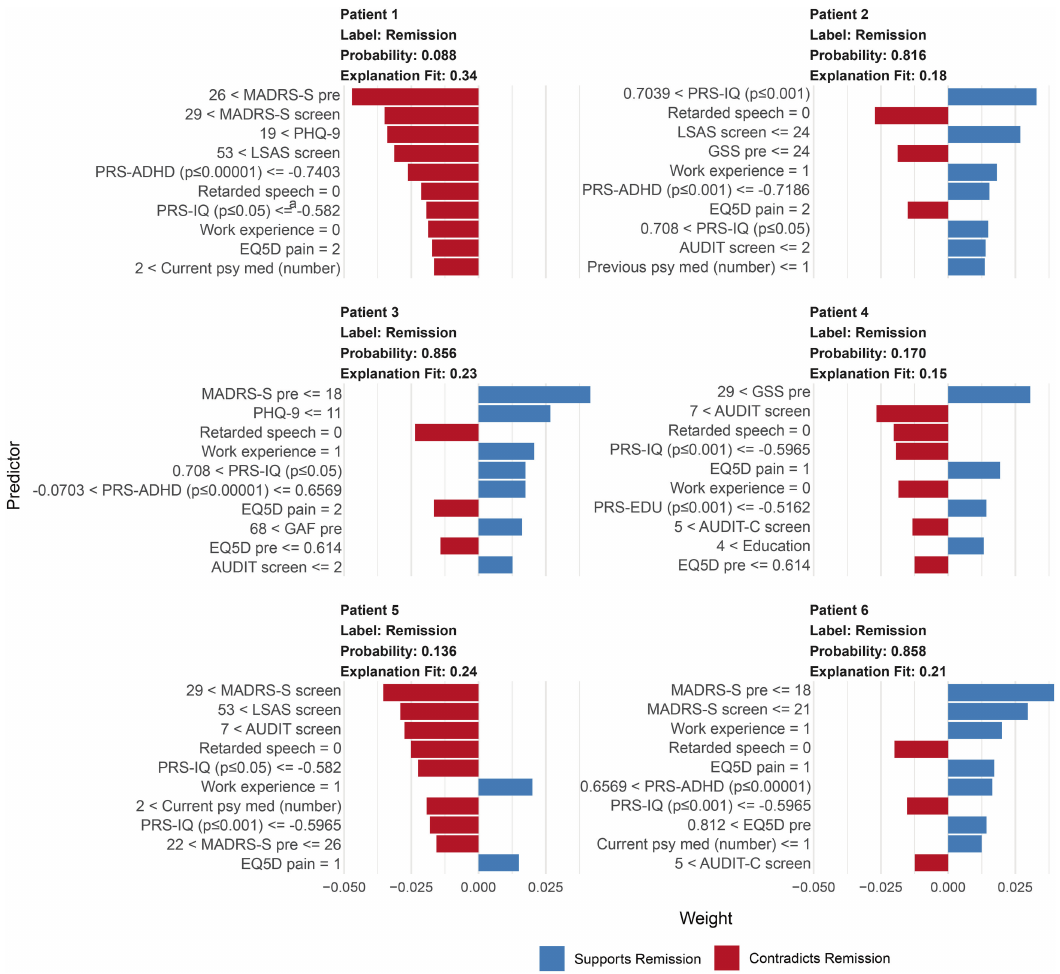
Fig. 5 Individual case predictions exempli fi ed with six individual patients. The top 10 predictors and their cut-off values in fl uencing the probability for post ICBT remission in each patient. Data are from the fi nal RF model with additional modelling using the LIME